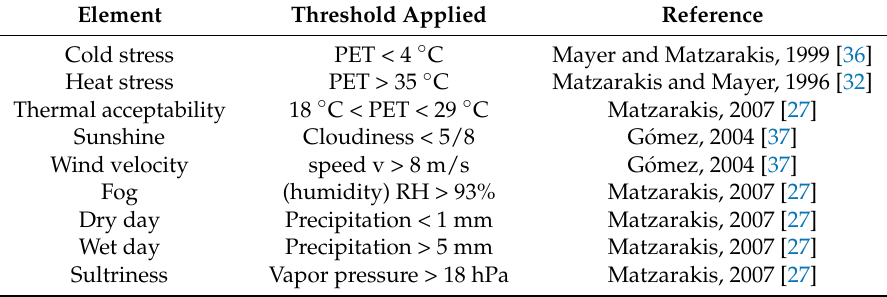
Table 2. Thresholds used for climate and bioclimate parameters relevant for tourism and references in the elaboration of the Climate-Tourism-Information-Scheme (CTIS)